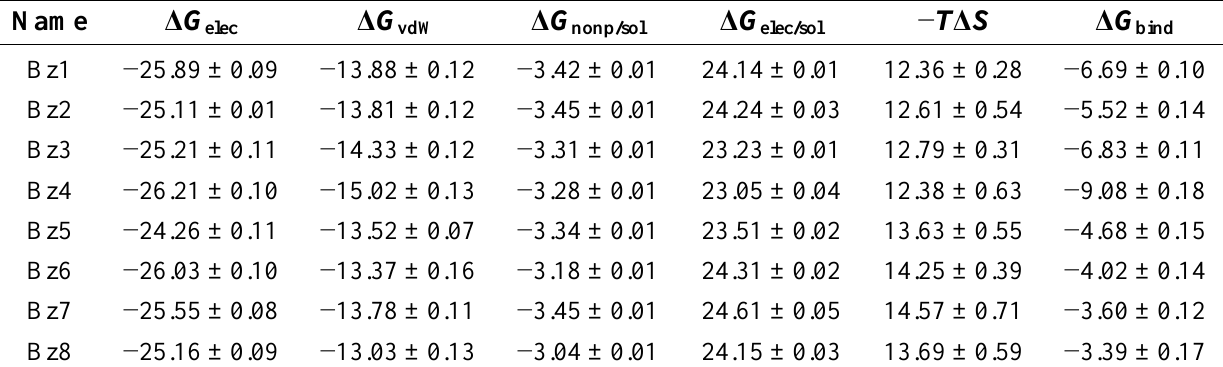
Table 2. The calculated values for binding free energies of HRgpA complexed with benzamidine analogs. The electrostatic portion was calculated within the PB approach; the nonelectrostatic contribution was calculated using SASA methods. The binding portion is the sum of electrostatic and non-electrostatic contributions. All energy values are presented in kcal/mol. The uncertainties are the standard error of the mean calculated with 200 snapshots (50 snapshots for entropic